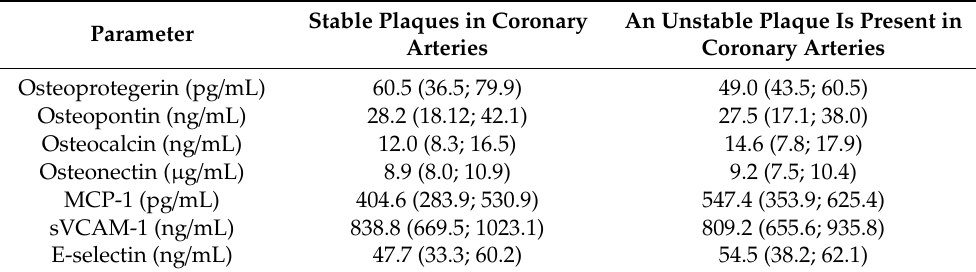
Table 4. Biochemical parameters of calcification and of endothelial dysfunction in the blood of males with coronary atherosclerosis, depending on plaque stability (Me (25%; 75%)).